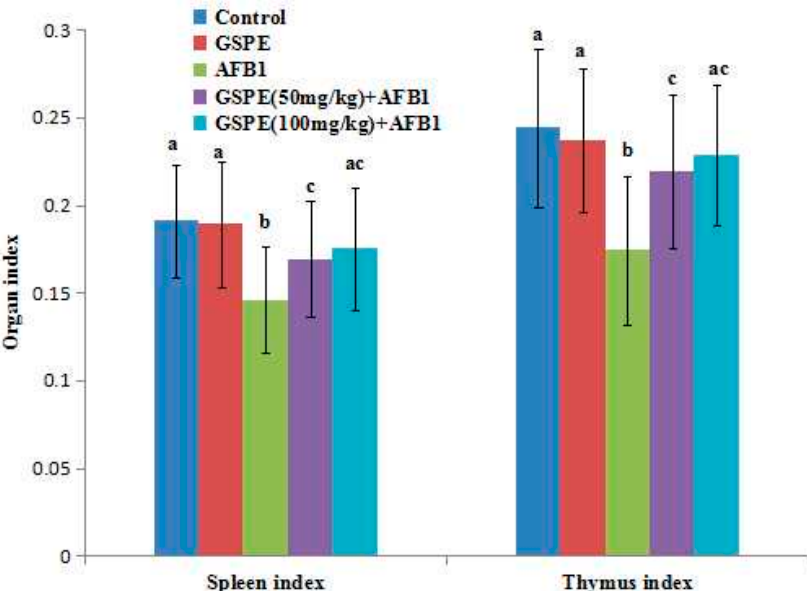
Figure 2. Effect of AFB1, GSPE, and their co-treatment on spleen index and thymus index in mice. Values are mean ± SEM of ten mice in each group. a, b, c Means with different letters are significantly different ( p < 0.05).